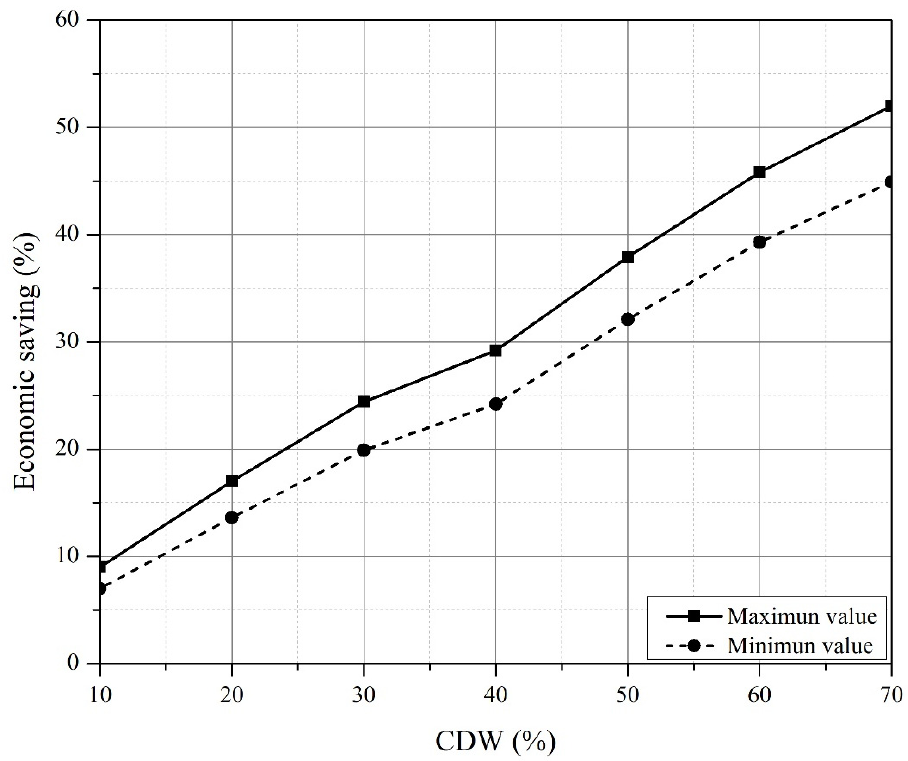
Figure 14. Percentage decrease in pavement structure cost by adding CDW to the subgrade.